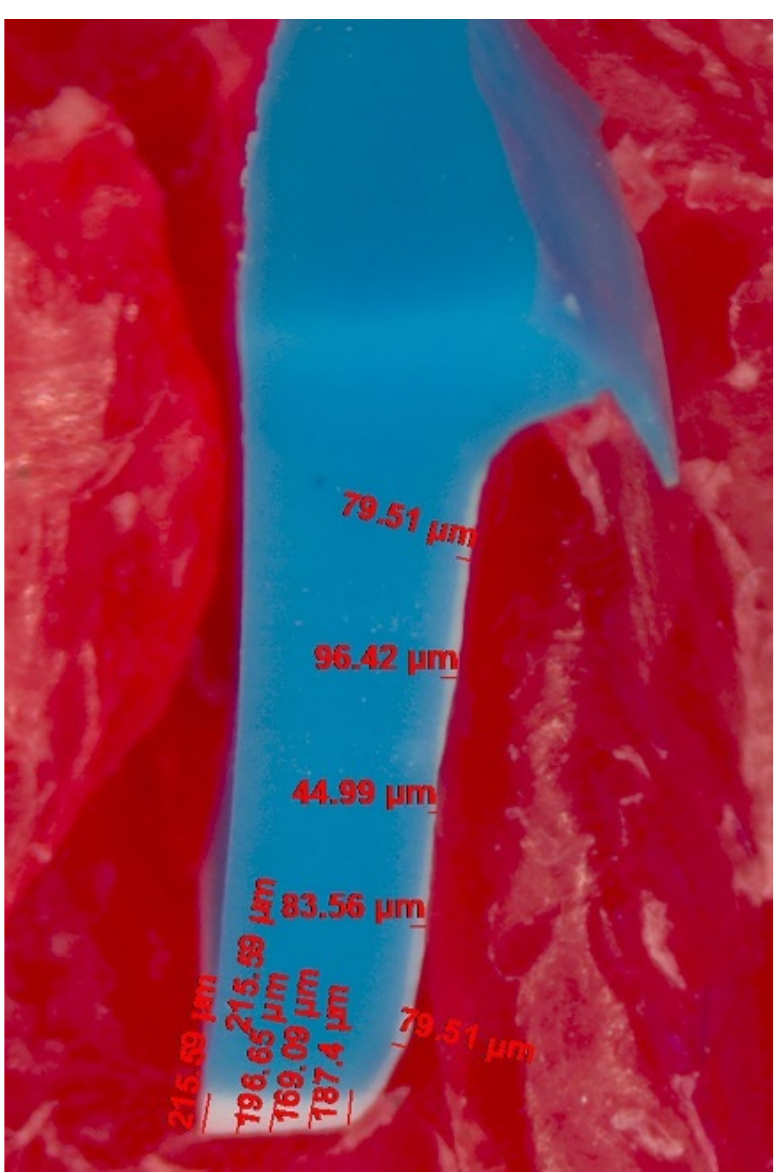
Figure 7. Stereomicroscopic image of the silicone replica cut section (indicated by the white layer) for PICN crown (zone 2) showing the IG measurement scheme on the axial and occlusal wall with representative values. The MG, AMD, and IG measurements were all carried out by the same assessor (M.E), at each of the 6 margin locations [29]. An average of 3 measurement repetitions at every marginal site were recorded as the final value. Intra-operator reliability assessment showed intra-class correlation coefficients of 0.95 for MG and 0.90 for AMD ( α = 0.05), suggesting excellent agreement for the investigator for the measurements at different